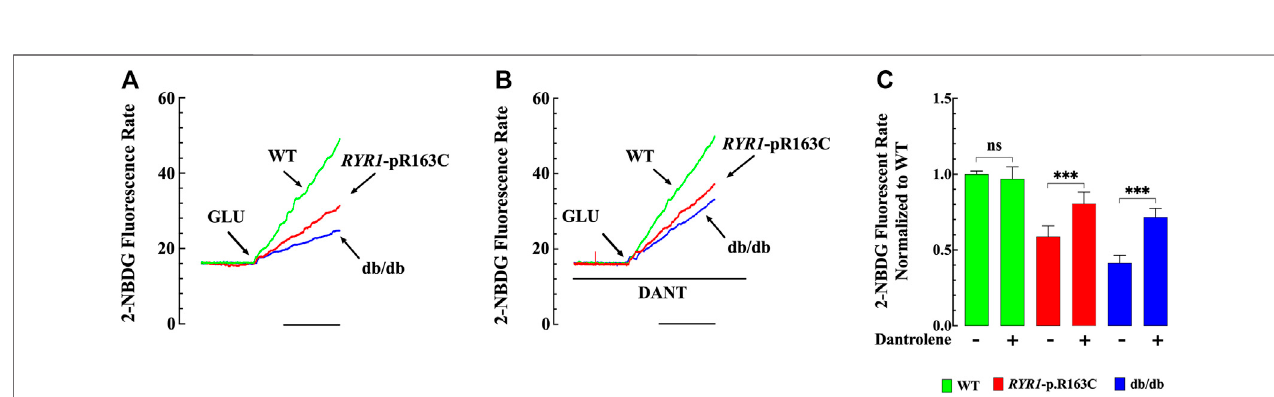
FIGURE 6 | Glucose uptake in WT, RYR1 -p.R163C, and db/db single fi bers. Effects of dantrolene. (A) Single muscle fi ber recordings of 2-NBDG fl uorescent signals from WT, RYR1- p.R163C, and db/db muscle. (B) Typical records of NBDG fl uorescent signals show the effect of dantrolene on insulin-dependent glucose uptake in single muscle fi bers WT, RYR1 -p.R163C, and db/db. (C) Shows the summary of abnormal insulin-dependent glucose uptake in RYR1- p.R163C and db/db single muscle fi bers and the effects of dantrolene. The fl orescent rate values were normalized to untreated WT and expressed as mean ± S. D; experiments were carried out in n mice = 5 per genotype; n fi bers = 9 – 14/genotype group. Statistical analysis was performed as described above. *** = p < 0.001. Calibration bar = 5 min.